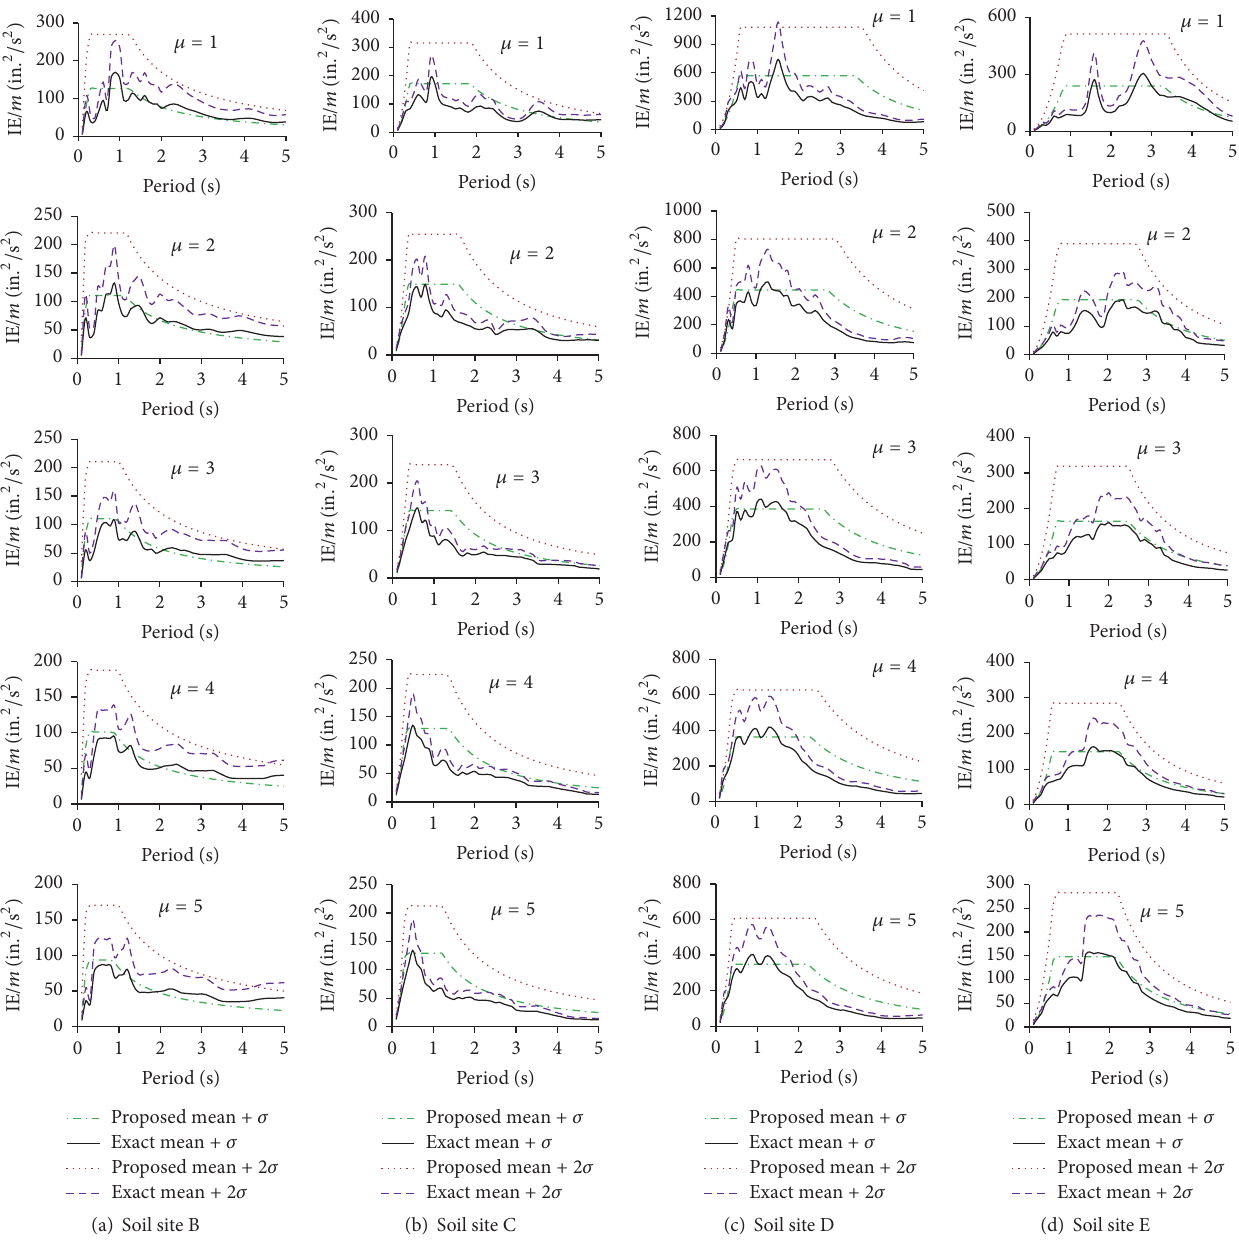
Figure 8: Comparative study of proposed input energy spectra: hysteresis model BF (𝜁 = 5 %, 𝛼 = 0.05)